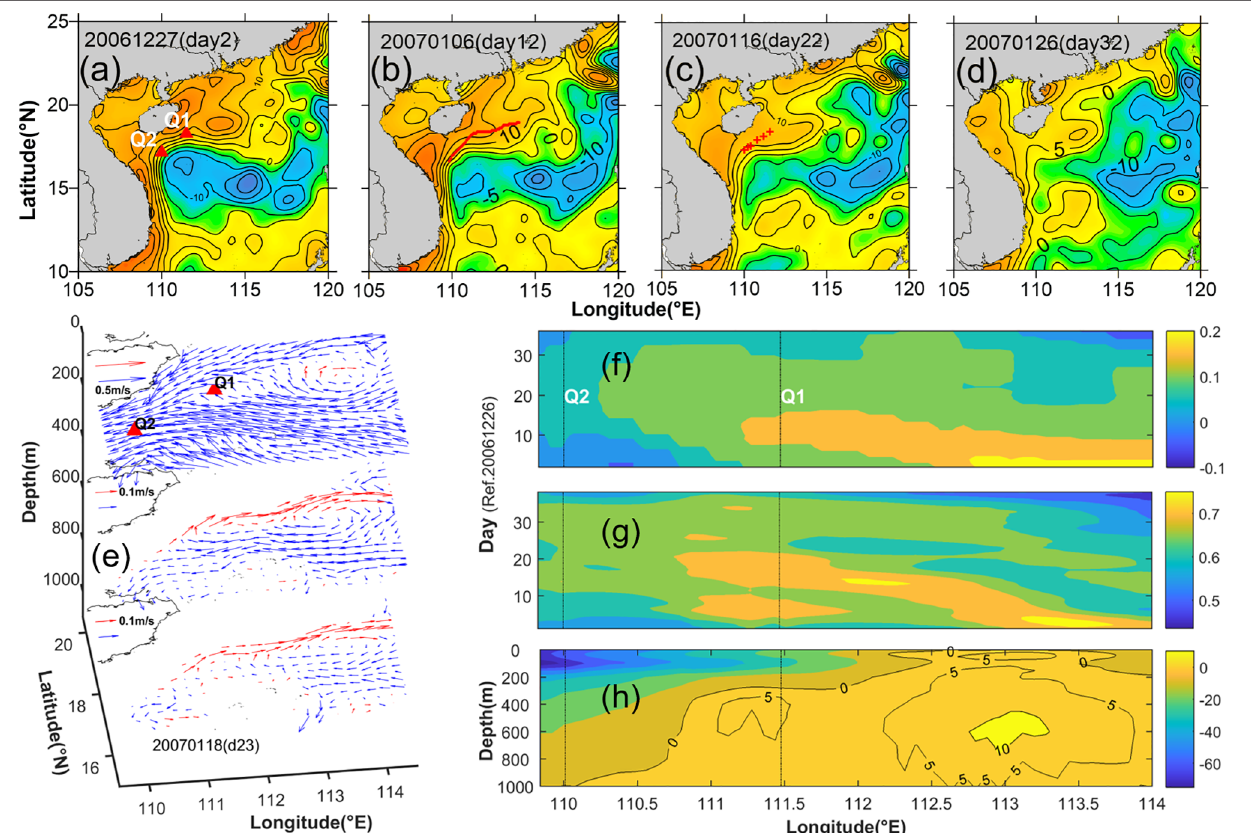
FIGURE 11 | (A–D) The sea level anomaly (cm) from altimetry observed with 10-days interval from day 2 to day 32. The red triangles in (A) , red line in (B) and red crosses in (C) denote the mooring stations, the 1000-m isobath and the CTD stations, respectively. (E) HYCOM-output 3D velocity field within the 1000-m depth; the slope undercurrent was highlighted with red arrows. The spatiotemporal evolution of the observed sea level anomaly (F) and the simulated sea level (G) along the 1000-m isobath ( F , G with unit: m); vertical axis starts at 26 December 2006 (Beijing Time, UTC+8). (H) The mean along-slope current (cm/s) simulated by HYCOM along the 1000-m isobath during the mooring period in deep winter of